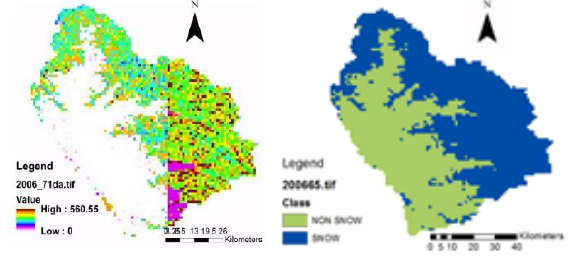
Figure 4.13. SWE (12 th Mar) Snow Cover (12 th Mar)